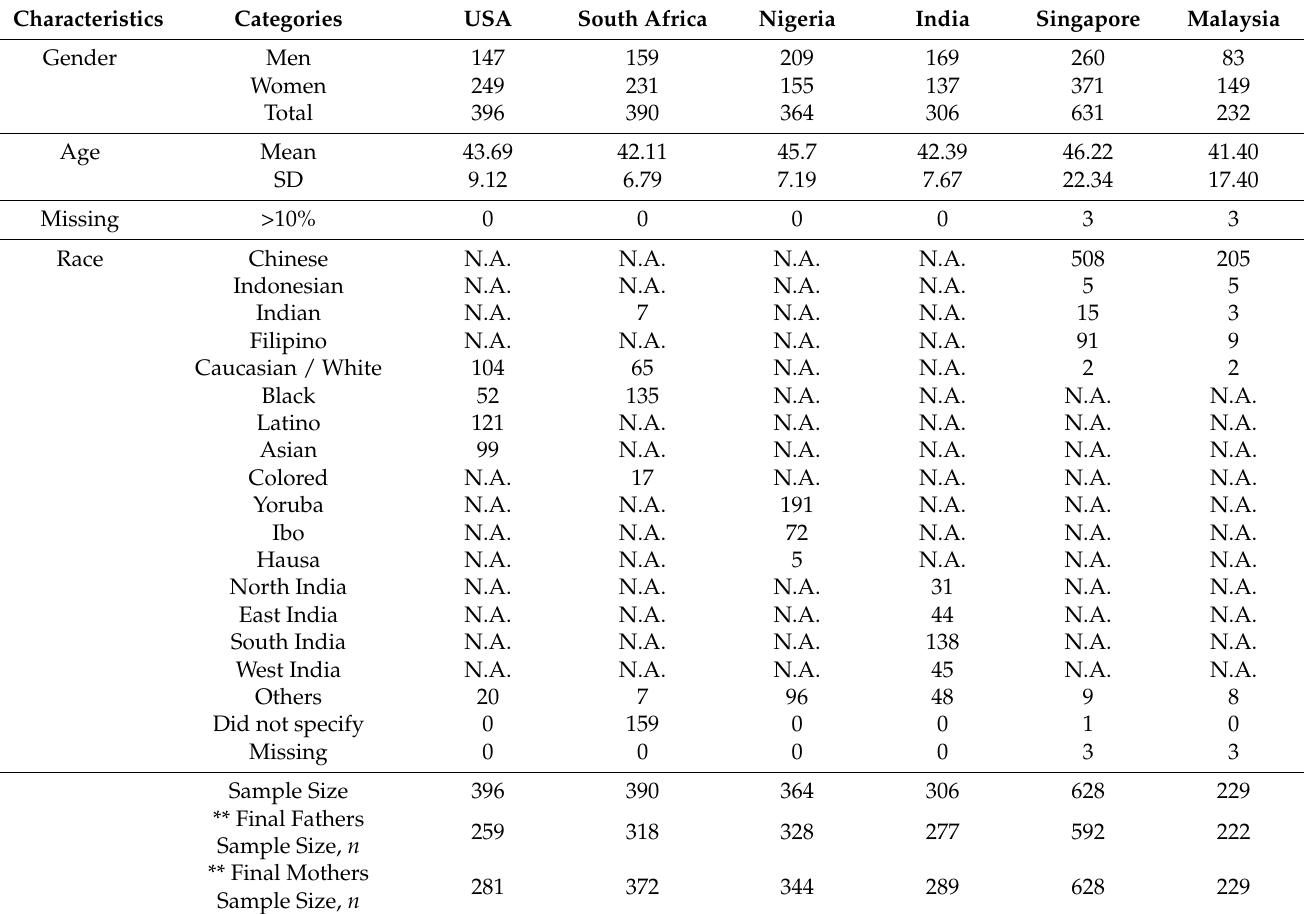
Table 1. * Demographic Characteristics of